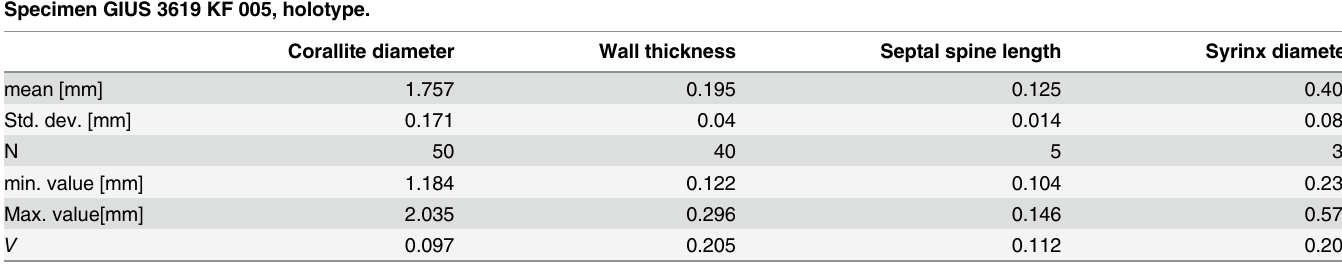
Table 2. Intracolonial variation in Syringopora kowalensis sp. nov. Specimen GIUS 3619 KF 005, holotype.